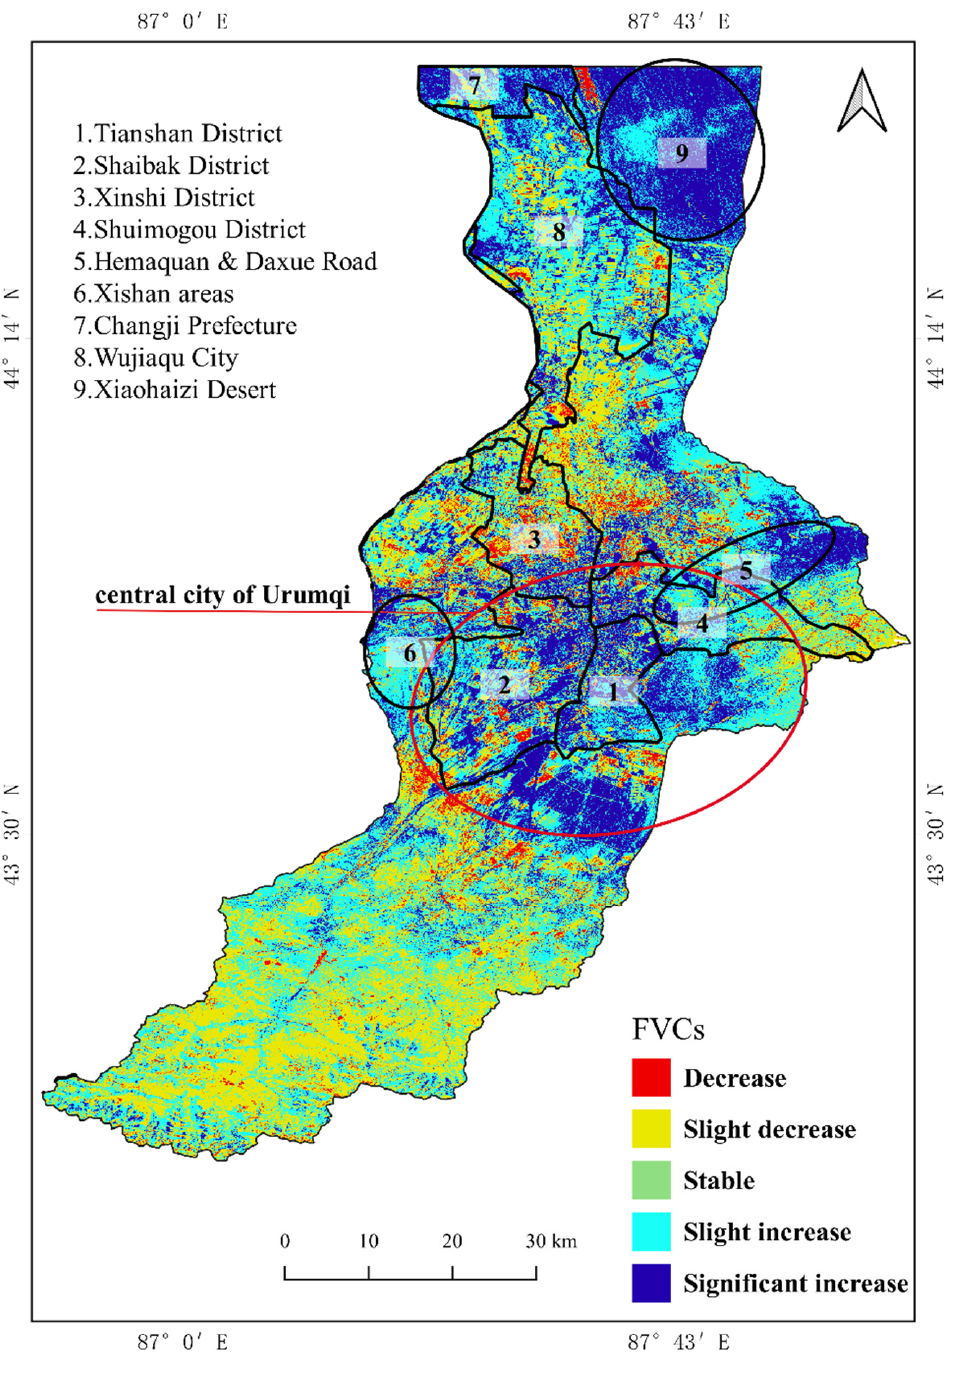
Figure 6. Trend of the FVC from 2000 to 2020.